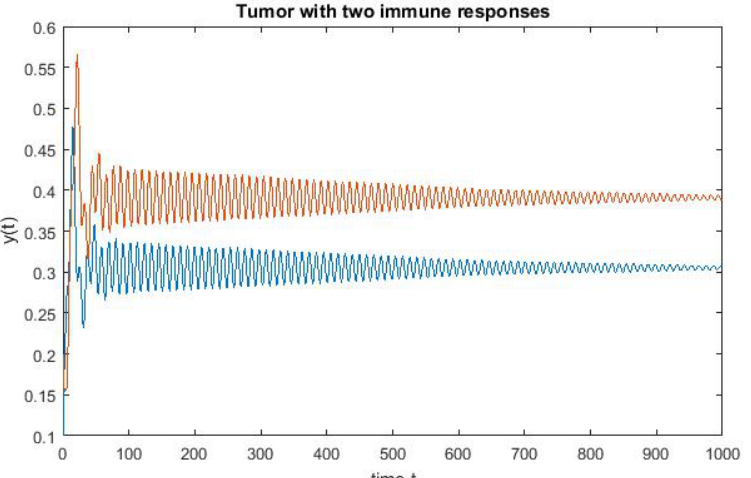
Figure 12. Simulation result of tumour populations at interphase (blue line) and mitosis (red line) when τ = 5.99 for the system (1) at E 1 = ( 0.1,0.39,2.62,11.41 ) .